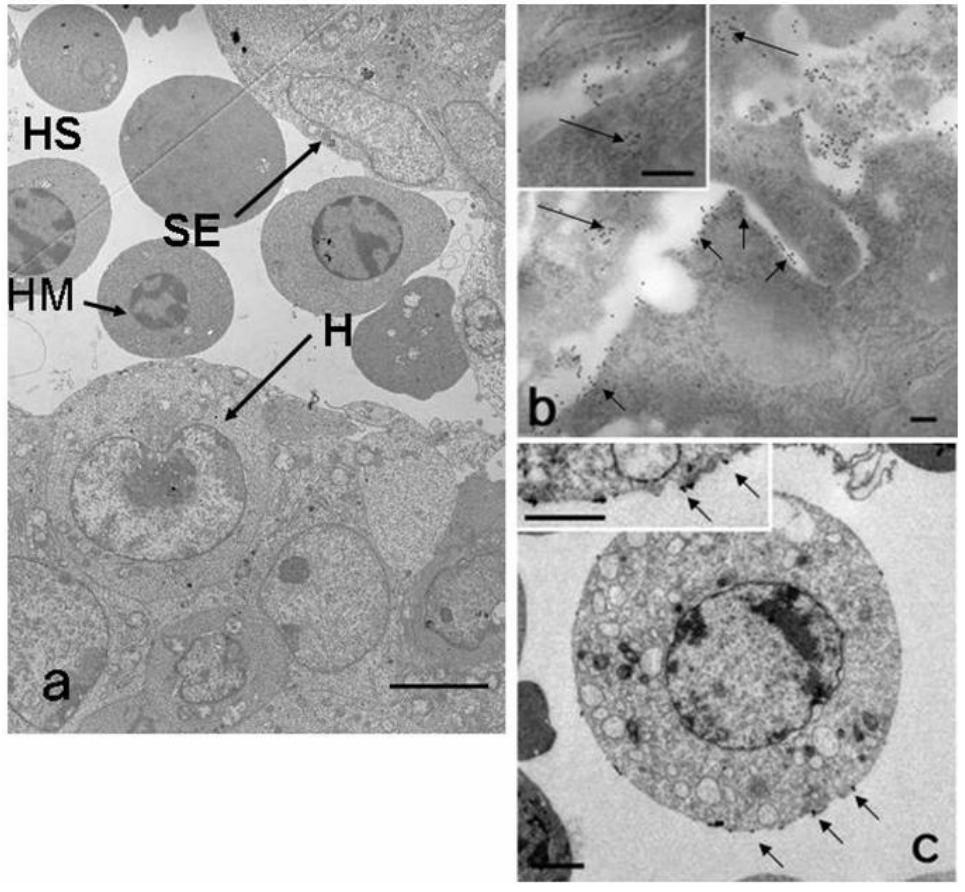
FIGURE 4. Ultrastructure of E11.5 immature hepatocytes. (a) TEM images of E11.5 hepatoblasts. Hemocytes were observed in the hepatic sinusoids, and endothelial cells and hepatoblasts (H) were observed underneath. (b) ImmunoGold as immuno-TEM images of E11.5 hepatoblasts immunoreactive with Liv2. The preferential distribution of gold particles for Liv2 was evident at the cell boundary and in vesicles close to the cell membrane. Inset in (b) shows higher magnification of another region. (c) Iron bead clusters (arrows) were detected on dissociated immature hepatocytes of E9.5 treated with Liv2 antibody and immunoiron beads. Inset in (c) is higher magnification of the part of the cell surface membrane to show definite iron beads (arrows). Bars = 5 µ m (a); 200 nm (b); 1 µ m